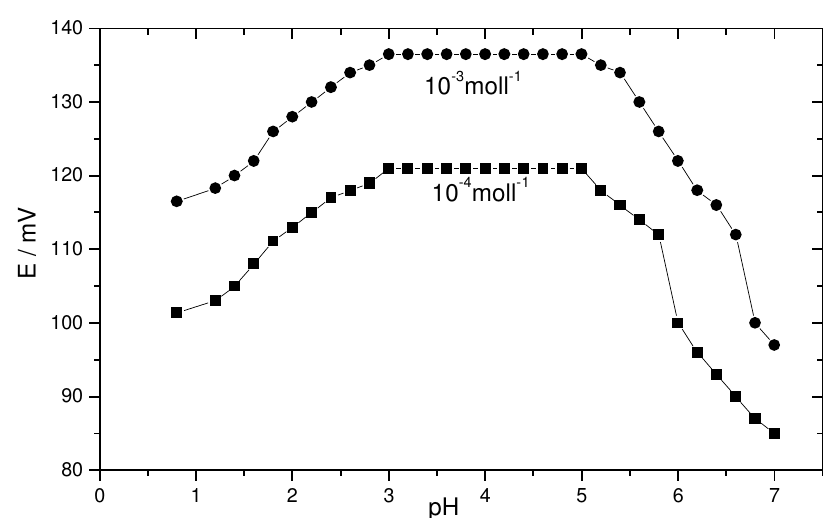
Figure (2) Effect of pH on the potentiometric response of the coated graphite rod-based thorium electrode.